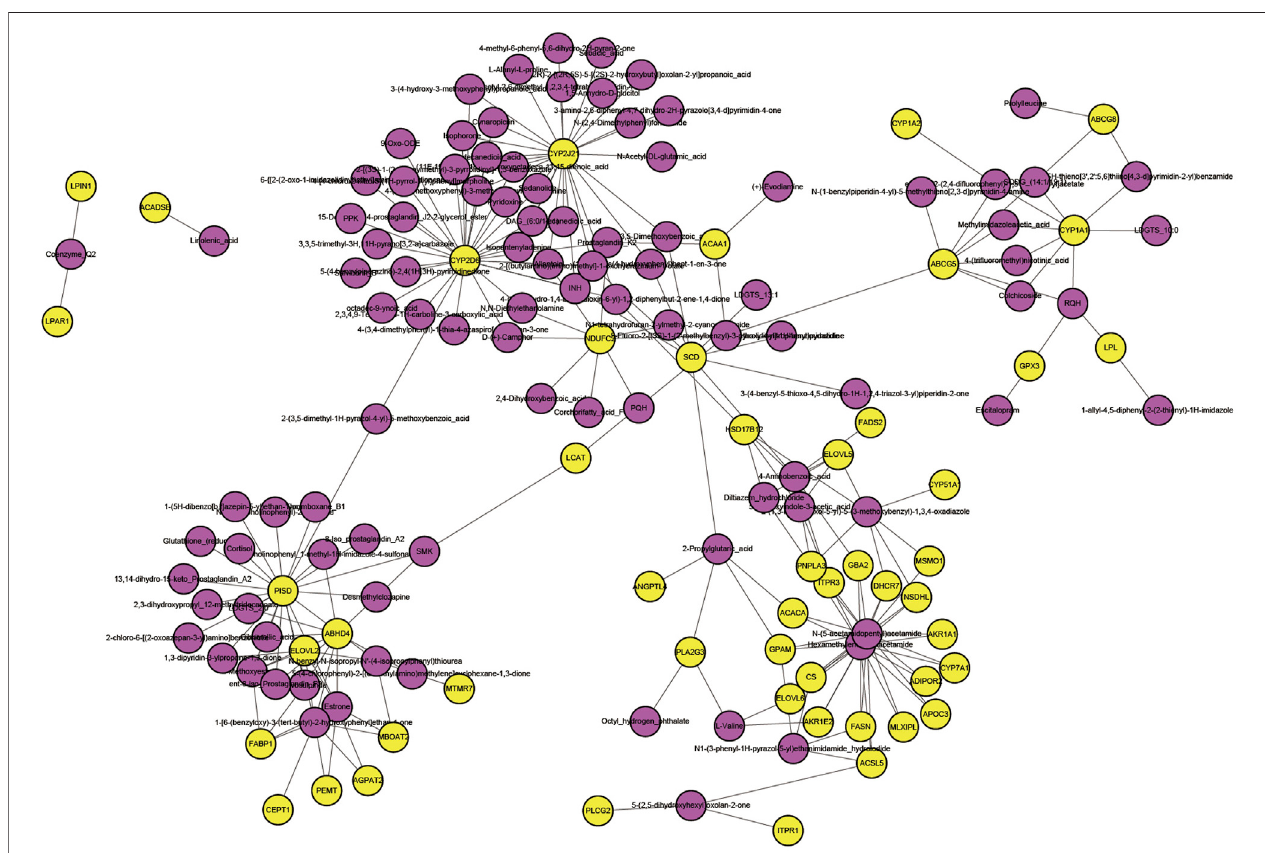
FIGURE 7 | Network interactions of key genes and differential metabolites; yellow represents genes and pink represents metabolites.